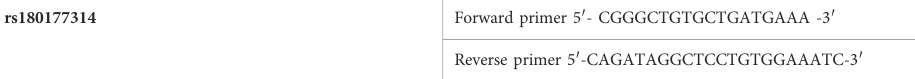
TABLE 5 Primers for sanger validation of rs180177314 of GRHPR gene.